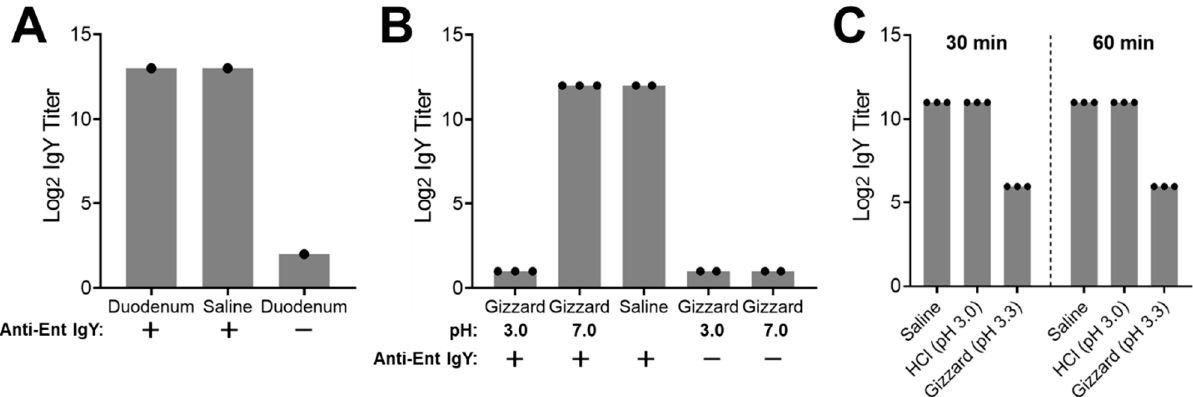
Figure 4. Ex vivo stability of the specific egg yolk IgY in duodenum and gizzard contents. ( A ) Ex vivo stability of the specific egg yolk IgY in the duodenum. The duodenum content was spiked with the hyperimmune egg yolk IgY and incubated at 42 °C for 2.5 h, followed by ELISA analysis of the specific IgY titer. The saline spiked with the hyperimmune egg yolk IgY served as a positive control while the duodenum content without addition of the egg yolk IgY served as a negative control (detailed in Materials and Methods). ( B ) Ex vivo stability of the specific egg yolk IgY in the gizzard. The gizzard content (pH 3.0 or 7.0) was spiked with the hyperimmune egg yolk IgY and incubated at 42 °C for 1.5 h, followed by ELISA analysis of the specific IgY titer. The saline spiked with the hyperimmune egg yolk IgY served as a positive control while the gizzard contents without addition of the egg yolk IgY served as negative controls. ( C ) Effect of pH and incubation time on ex vivo stability of the specific egg yolk IgY in the gizzard. Fresh gizzard content was collected and immediately subjected to an ex vivo stability assay. The freshly prepared gizzard content extract (pH 3.3) was spiked with the hyperimmune egg yolk IgY and incubated at 42 °C for 30 or 60 min, followed by ELISA analysis of the specific IgY titer. The hydrochloric acid (pH 3.0) and saline that were spiked with the egg yolk IgY served as controls. Each dot represents mean of duplicate measurements of an independent sample. Each bar represents mean ± SD of the indicated number of samples.